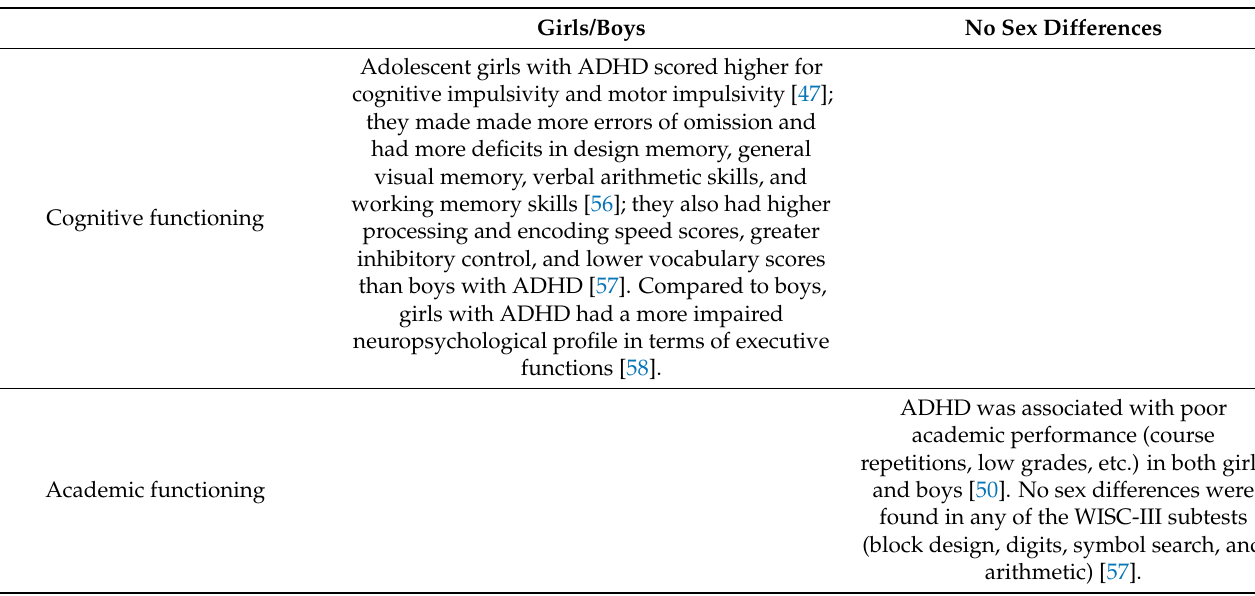
Table 4. Sex differences in cognitive and academic functioning.